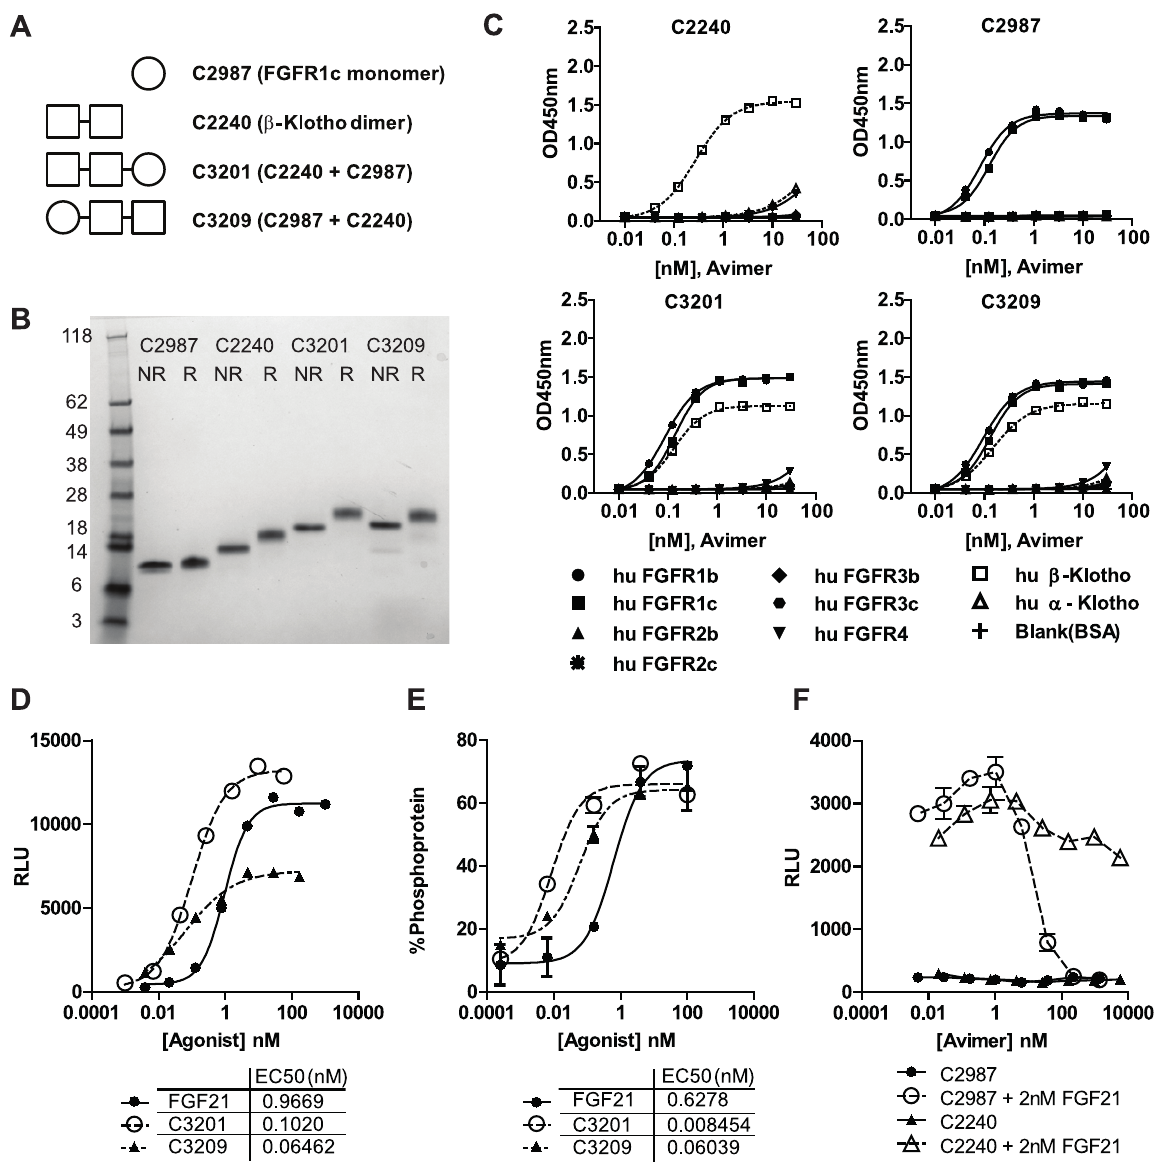
Figure 1. Design and characterization of FGFR1c/ b -Klotho bispecific Avimers. (A) Cartoon representation of FGFR1c monomer C2987 and b -Klotho dimer C2240 and orientation of these component Avimers in the bispecific Avimers C3201 and C3209. (B) Purified Avimers C2987, C2240, C3201 and C3209 analyzed by SDS-PAGE. 1 m g of protein was run per lane, with samples either reduced (R) or not reduced (NR). The upward shift on reduction is characteristic of Avimer proteins. (C) ELISA analysis of purified Avimers showing the specificity for both FGFR1c and b -Klotho is retained in the bispecific Avimers C3201 and C3209. Binding is measured by optical density (OD) at 450 nm. (D) Bispecific Avimers C3201 and C3209 induce luciferase activity in an FGF21-responsive engineered reporter cell line following four hour stimulation of serum-starved cells. Luciferase activity is measured in relative luminescence units (RLU). (E) FGF21 and bispecific Avimers C3201 and C3209 induce ERK phosphorylation in cultured primary human adipocytes. Data are expressed as % ERK protein that is phosphorylated, as measured by MSD. (F) Monospecific Avimers C2987 and C2240 were titrated on FGF21-responsive reporter cells + / 2 2 nM FGF21. The FGFR1c monomer C2987 antagonizes FGF21. Luciferase activity is measured in relative luminescence units (RLU). Data are represented as mean + / 2 SEM (n=2).